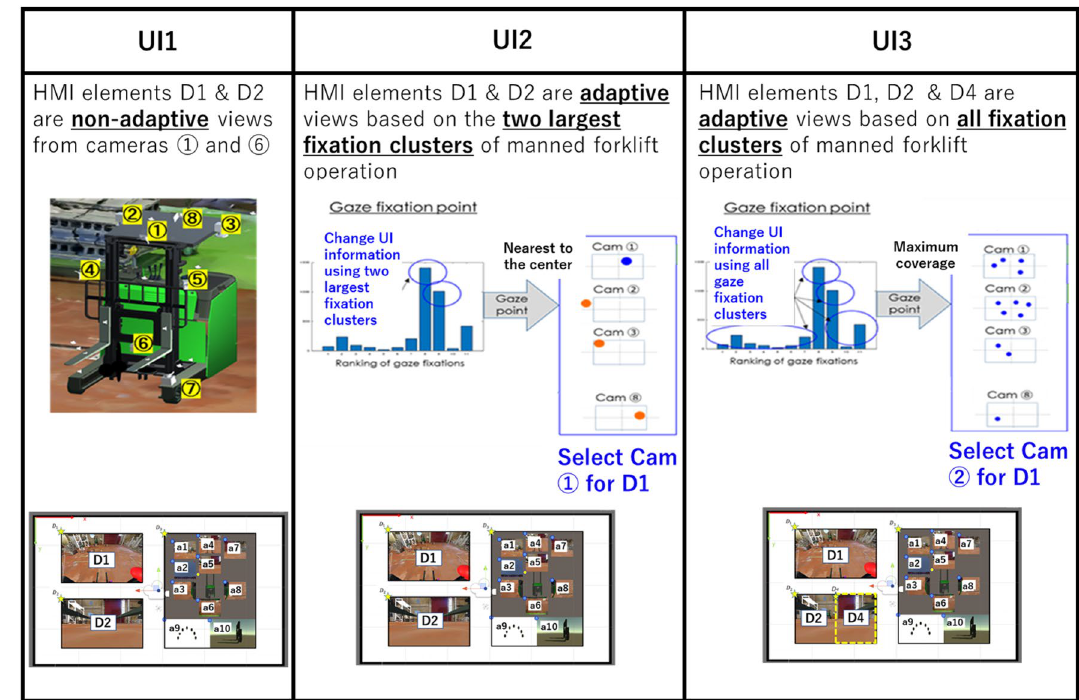
Figure 10. Illustration of the differences between HMI candidates for the usability